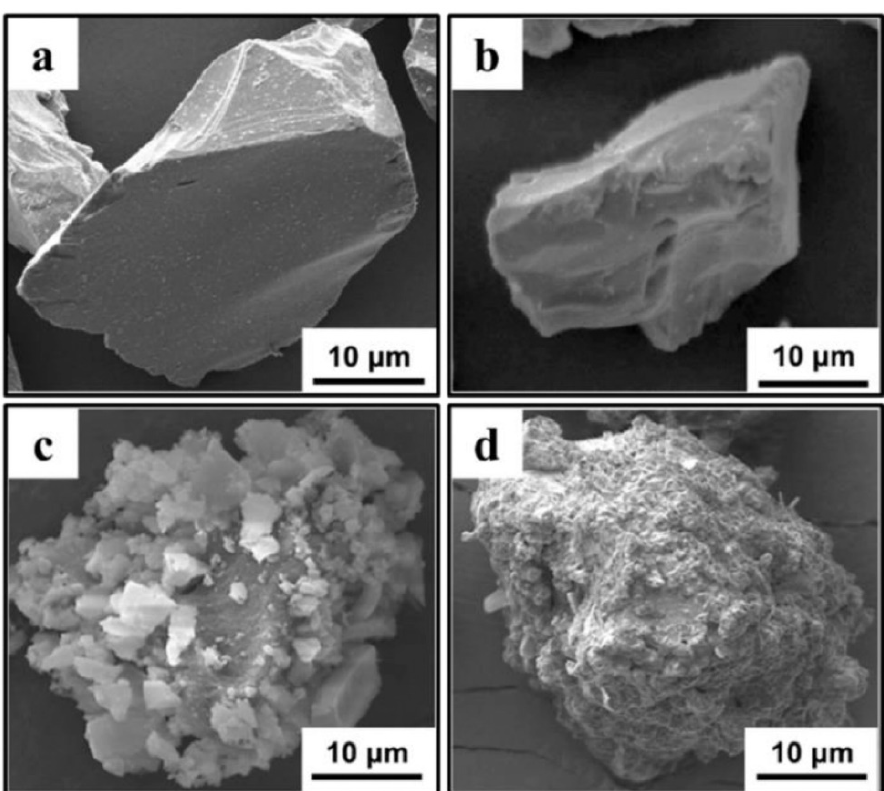
Figure 26. SEM images of commercial-SiC powder ( a ), commercial Al 2 O 3 powder ( b ), SG fabri- cated TEOS_SiC powder ( c ) and SG fabricated TEOS/SDS_SiC powder ( d ) . Reprinted with permis- TEOS_SiC powder ( c ) and SG fabricated TEOS/SDS_SiC powder ( d ). Reprinted with